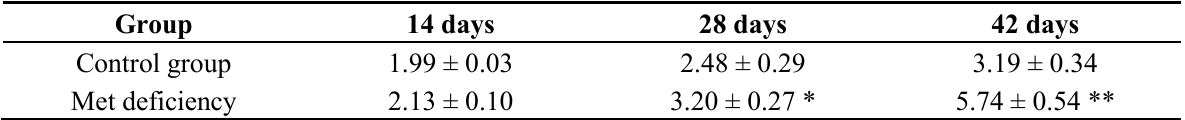
Table 4. Effect of Met deficiency on the percentage of apoptotic cells (%) in the bursa of